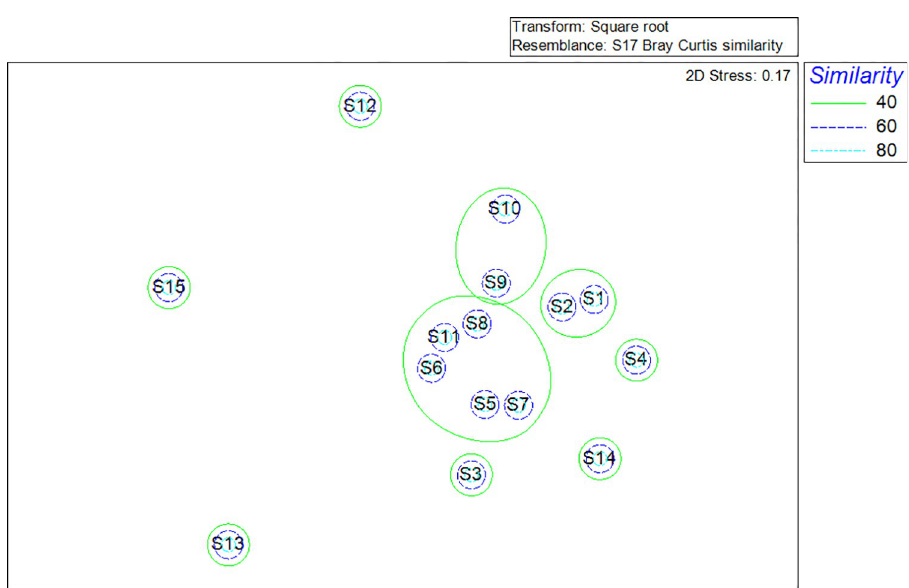
Fig 2. Multidimensional Scaling (MDS) illustrated the level of similarity of nematode species composition between stations.